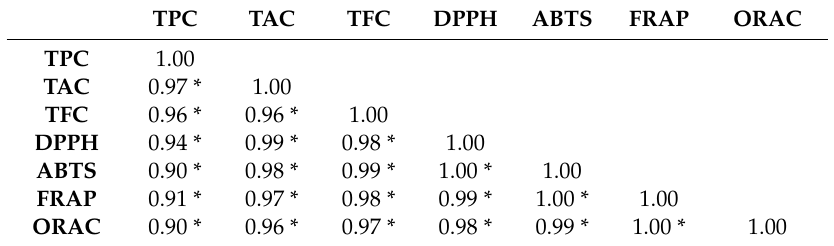
Table 6. Pearson’s correlation coe ffi cients (r) between biological active compounds content (TBC